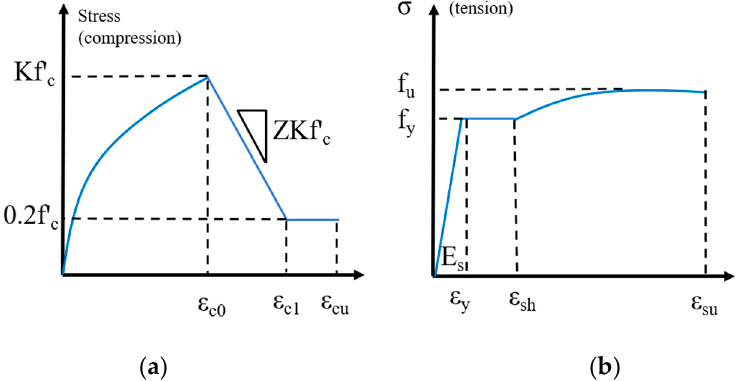
Figure 2. ( a ) Kent Park constitutive law; ( b ) Park Strain Hardening constitutive law.